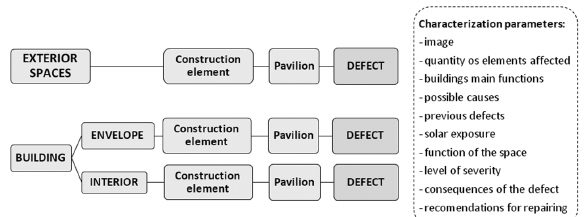
Fig. 6. Organogram of the parameters included in the defects characterization